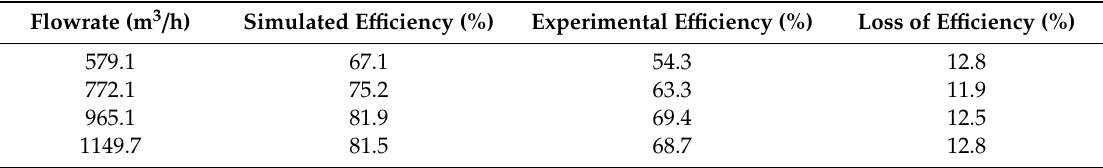
Table 4. The loss of efficiency between the simulation and the experiment.